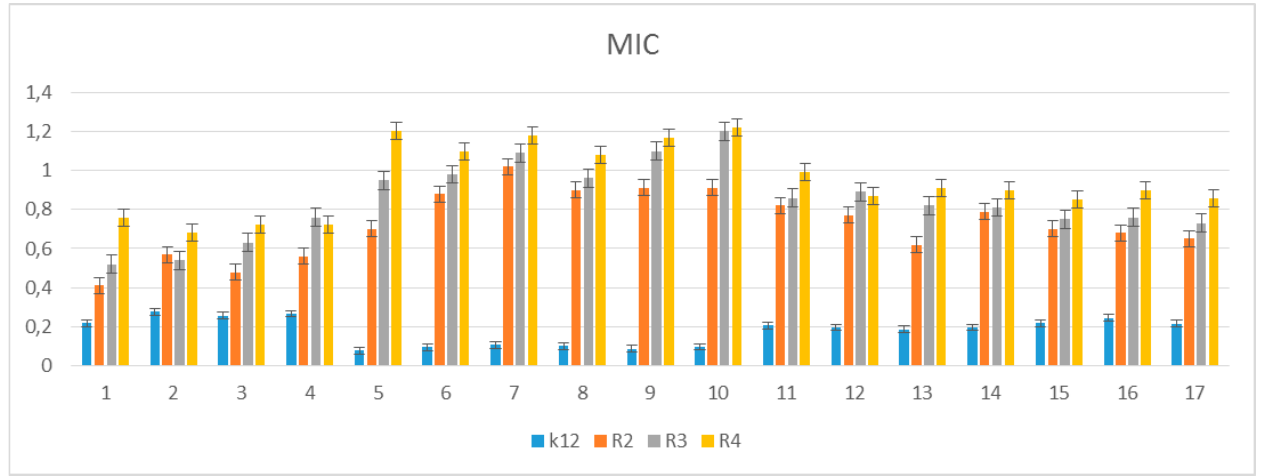
Figure 4. Minimum inhibitory concentration (MIC) of the lactones in model bacterial strains. The x -axis compounds 1–17 were used sequentially. The y -axis shows the MIC value in µg/mL − 1 .